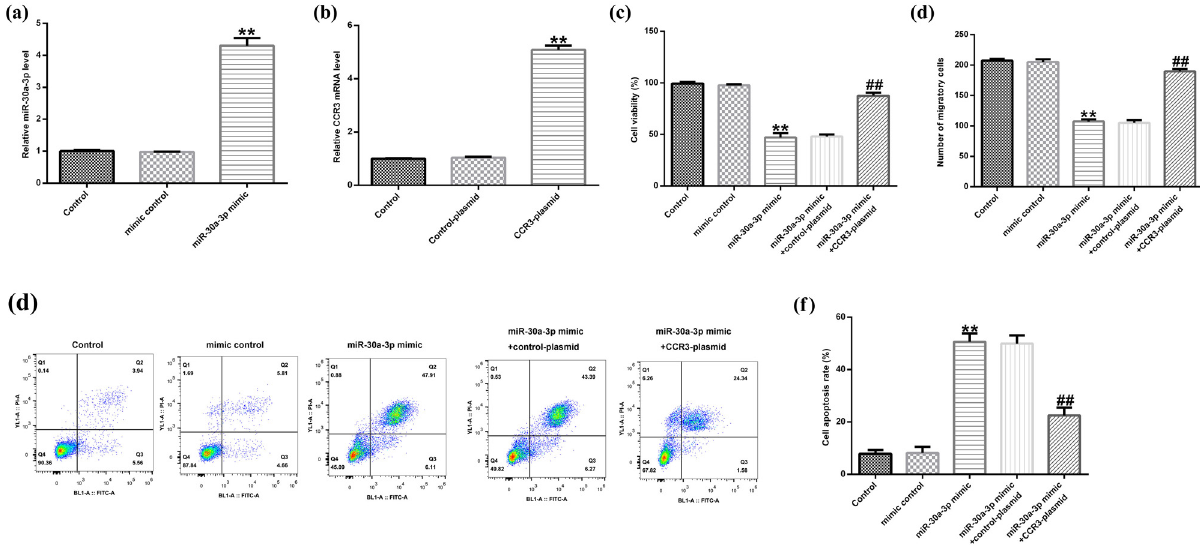
Figure 4: The e ff ect of miR - 30a - 3p mimic on the biological behavior of eosinophils. The gene expression levels of ( a ) miR - 30a - 3p and ( b ) CCR3 were determined using qRT - PCR. ( c ) Cell viability was determined using CCK - 8 assay. Eosinophils were transfected with miR - 30a - 3p mimic, mimic control, miR - 30a - 3p mimic + control - plasmid, or miR - 30a - 3p mimic + CCR3 - plasmid. ( d ) Cell migration